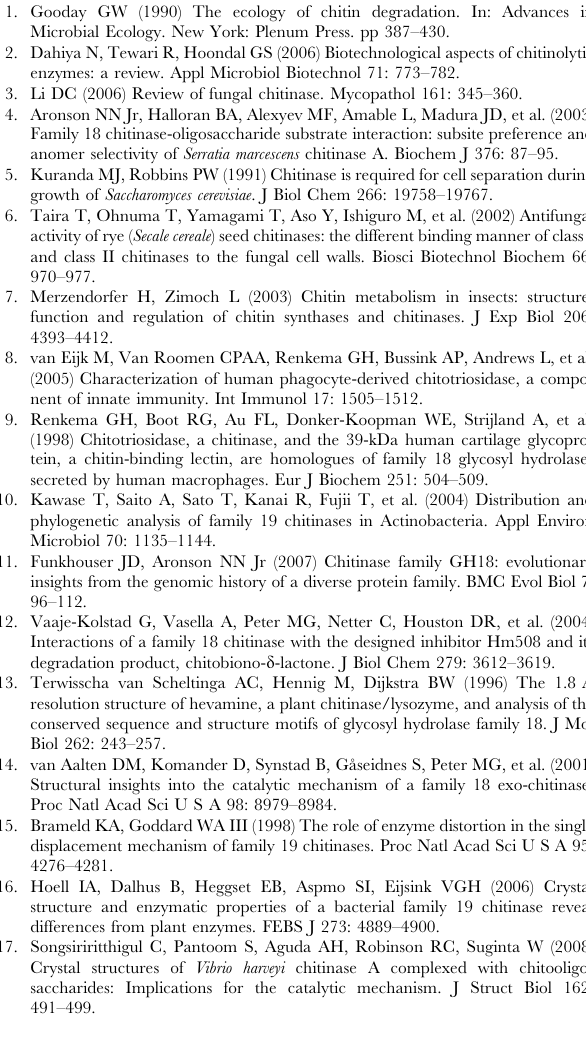
Table S2 List of the sequence names, species name, and GI numbers of thirty-three more CID sequences that are included in the phylogenetic tree (Fig. 5) and the larger multiple sequence alignment (Fig.